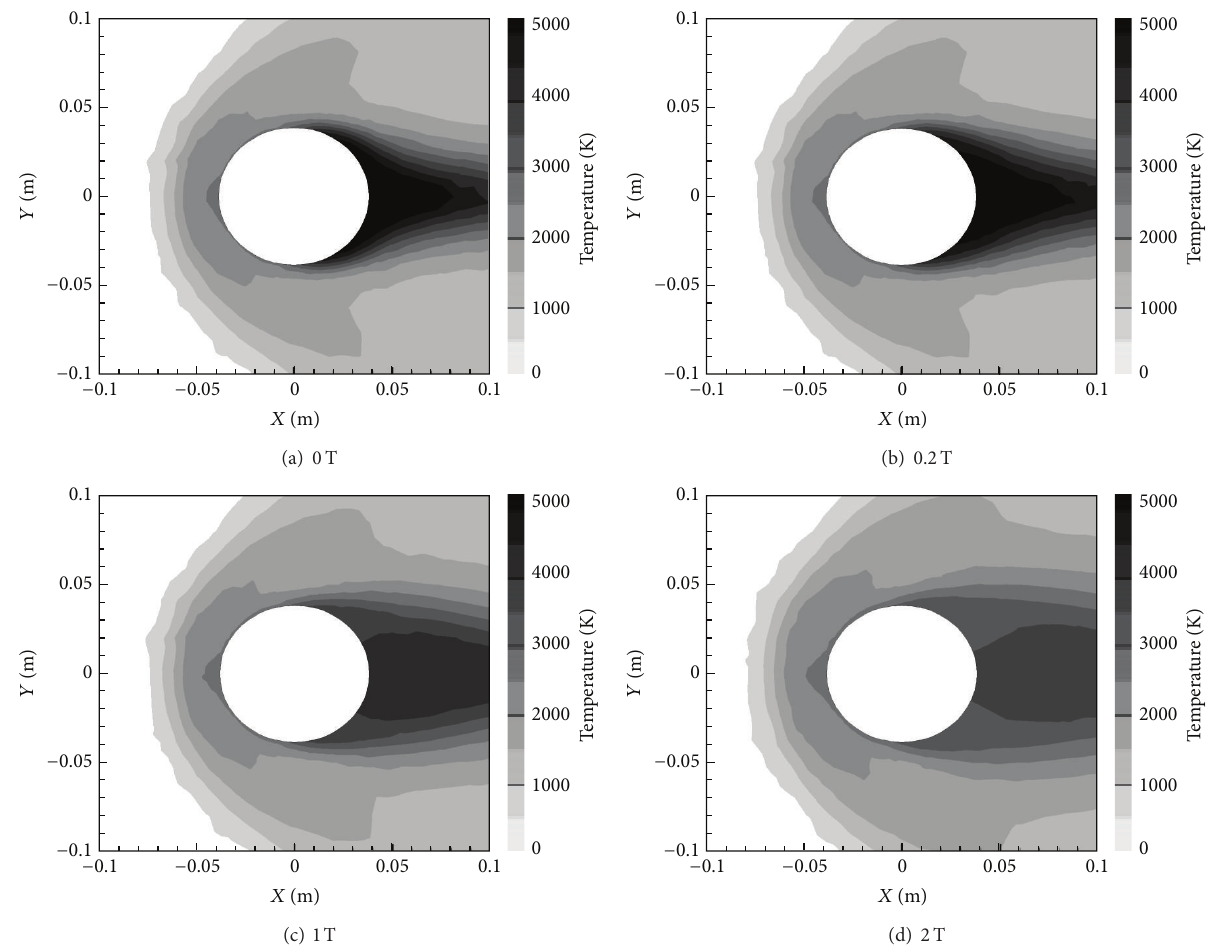
Figure 8: Temperature contours for various 𝐵 max with 𝑋